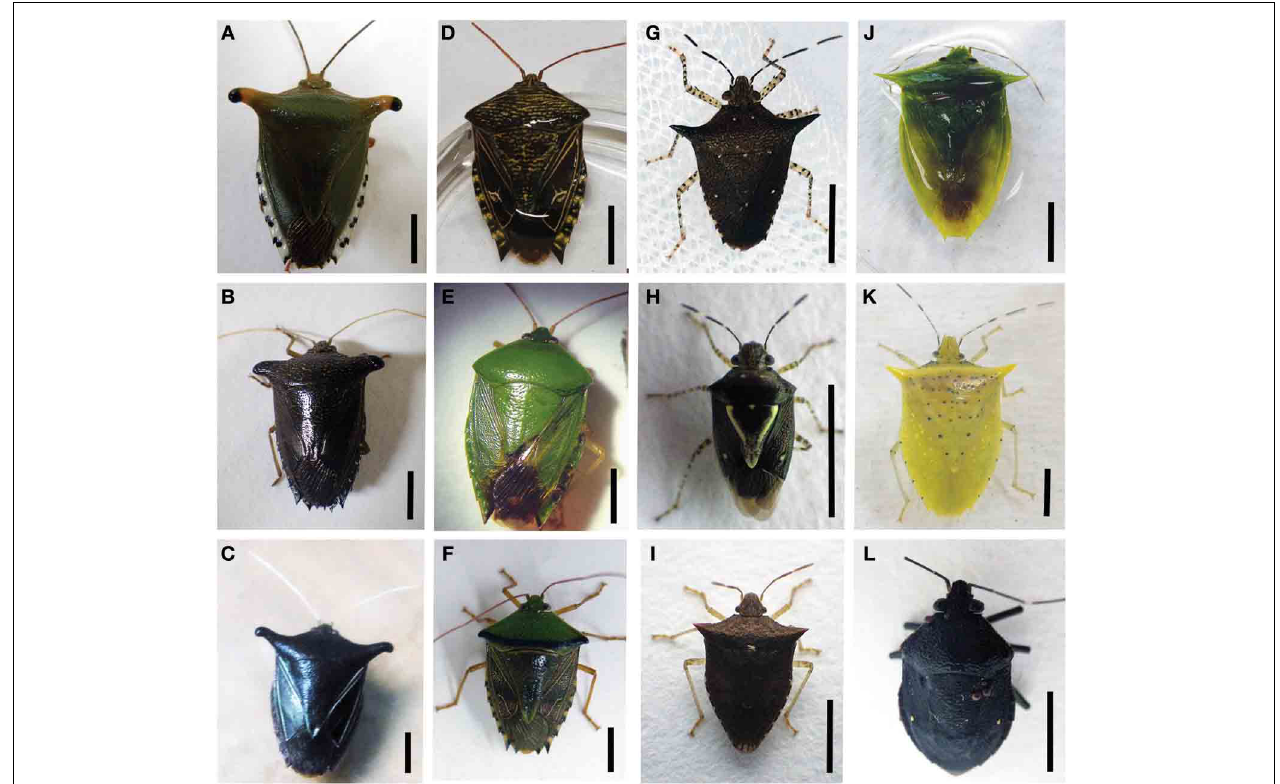
FIGURE 1 | Pentatomid specimens used in this study. (A) Edessa n sp 1 (B) Edessa bugabensis (C) Edessa jugata (D) Edessa aff. irrorata (E) Edessa junix (F) Edessa eburatula (G) Sibaria englemani (H) Mormidea